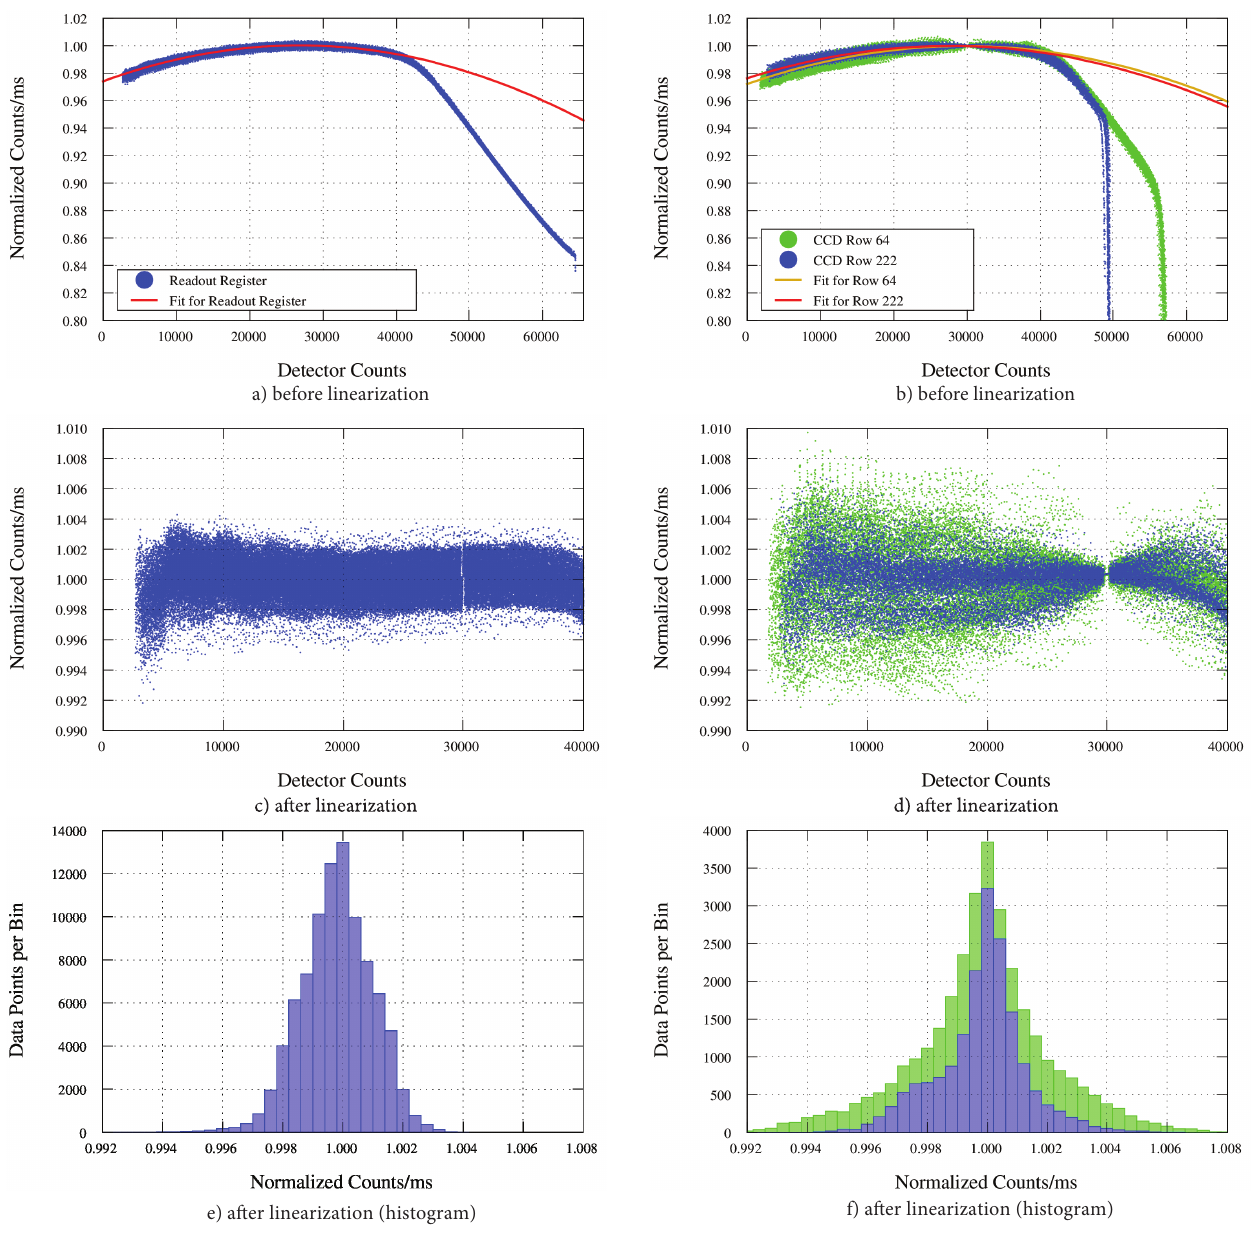
Figure 9. Results from a linearity test of HAIDI’s detectors. The displayed countsms are normalized to a reference value at an intensity level of 30000 counts. (a) , (b) Measured counts per millisecond in full vertical binning (left) and full frame readout mode (right). (c) , (d) Linearity of the analyzed pixel after correction by a second-order polynomial. (e) , (f) Histogram of the corrected